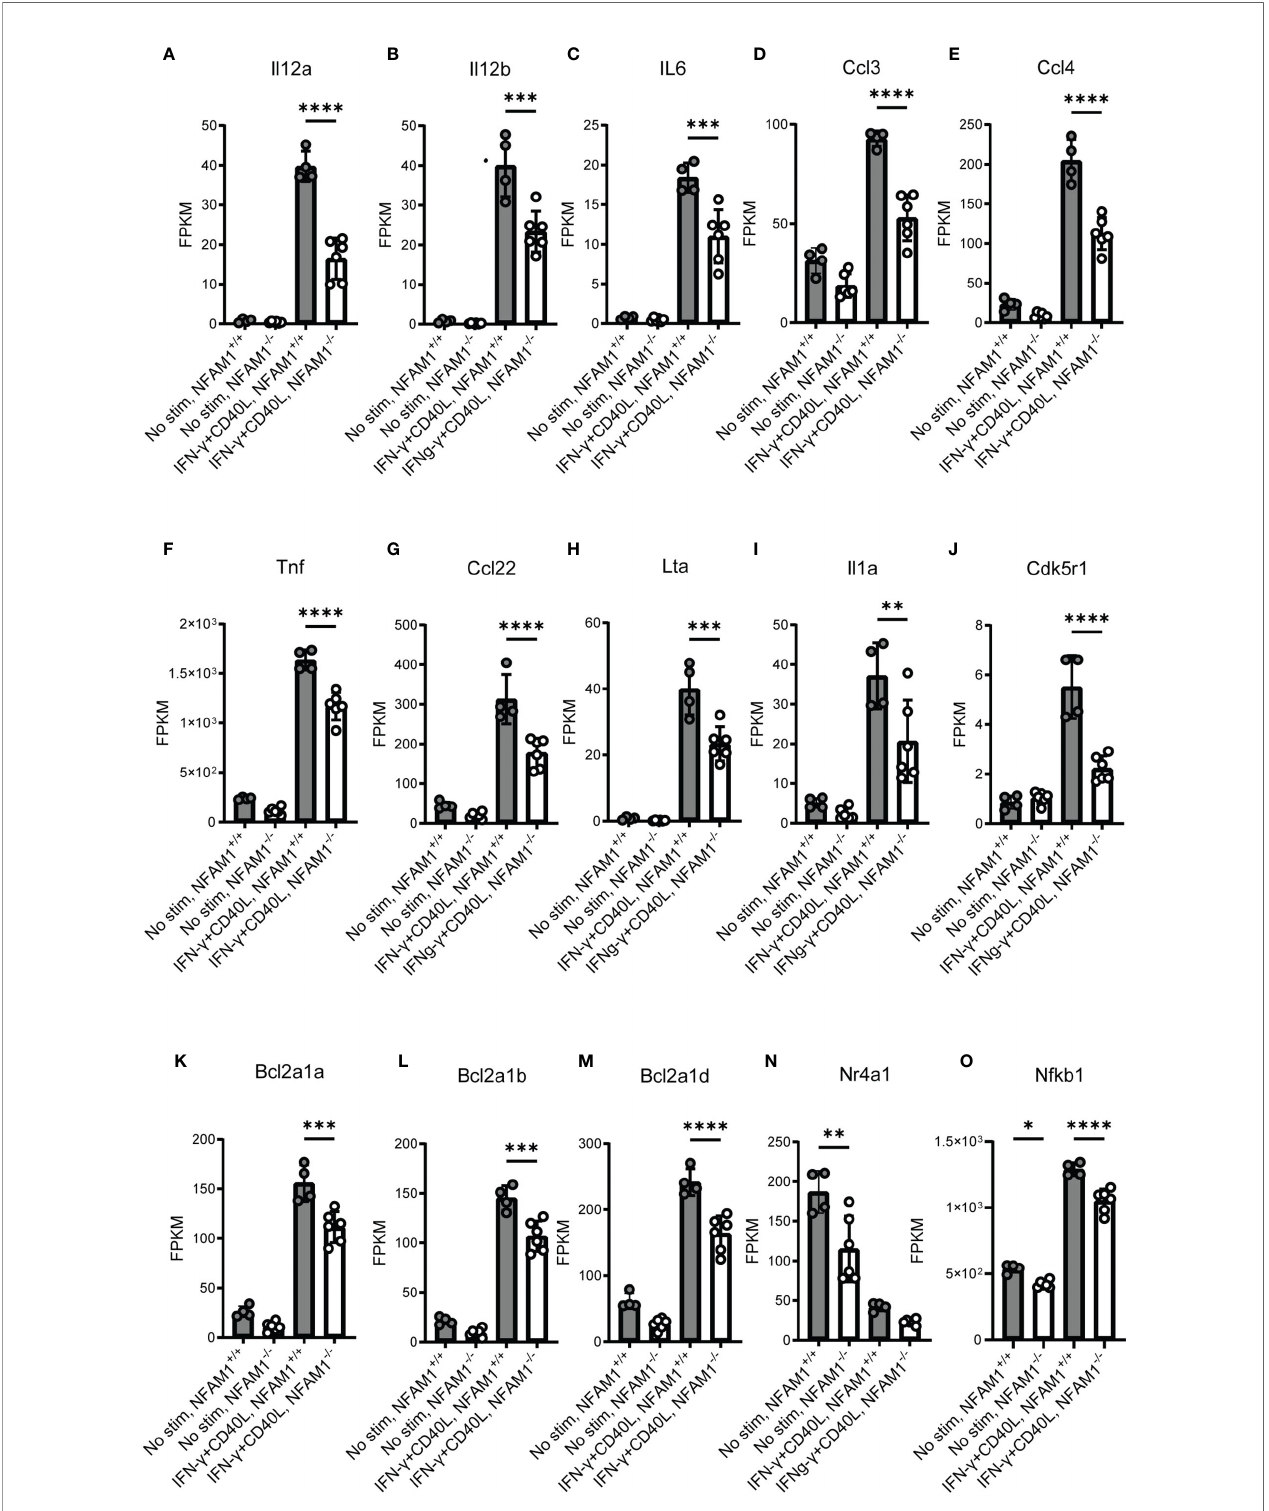
FIGURE 7 | RNAseq analysis con fi rms that NFAM1 -/- monocytes have reduced expression of CD40L-induced pro-in fl ammatory cytokines and chemokines. RNAseq was performed as described in Figure 6 . Mean FPKM for select genes at 6 hours is shown in (A – O) . Statistical signi fi cance is depicted as follows: **** indicates a P value of <0.0001, *** indicates a P value of <0.001, ** indicates a P value of <0.01, and * indicates a P value of